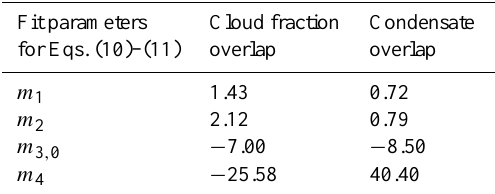
Table 1. Parameters for the Gaussian fits per Eqs. (10) and (11) of zonal decorrelation lengths shown in Fig. 1.